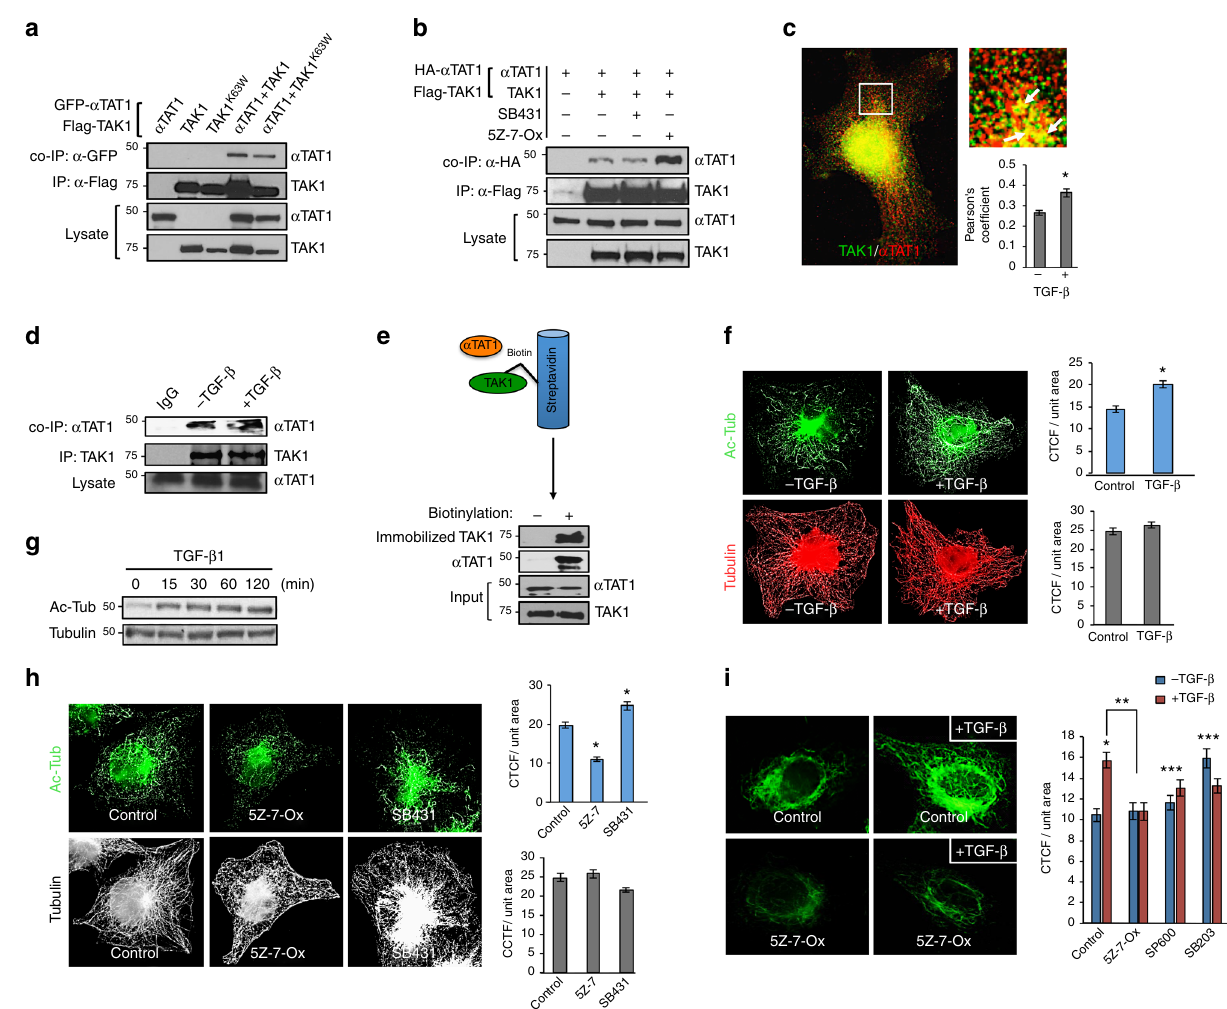
Fig. 1 TAK1 directly binds α TAT1 to promote MT acetylation. a COS-7 cells expressing HA- α TAT1 WT, Flag-TAK1 WT, or Flag-TAK1 kinase-dead (K63W) were immunoprecipitated with Flag antibody. b COS-7 cells expressing HA- α TAT1 WT with or without Flag-TAK1 WT were treated with SB431542 (30 μ M) or (5Z)-7-Oxozeaenol (20 μ M) for 30 min before immunoprecipitation with Flag antibody. c COS-7 cells were treated with TGF- β 1 (200 pM) for 30 min before fi xing and then imaged for endogenous α TAT1 (C6ORF) and TAK1 immuno fl uorescence staining. At least 15 cells per condition (3 ROIs per cell) were quanti fi ed using Image J plugin JACoP to determine Pearson ’ s correlation coef fi cient. Error bars represent SEM from three independent experiments (* p = 0.0001). d COS-7 cells were treated with TGF- β 1 (200 pM) for 30 min and the lysates were immunoprecipitated with either IgG control or α TAT1 (C6ORF) antibody. e Puri fi ed α TAT1 and TAK1 were incubated with biotinylated TAK1 immobilized to streptavidin agarose. As a negative control, α TAT1 and non-biotinylated TAK1 were incubated in streptavidin agarose. f COS-7 cells were treated with TGF- β 1 (200 pM) for 30 min before fi xation, then imaged for acetyl-tubulin (top) and total tubulin (bottom) immuno fl uorescence staining. The images were quanti fi ed for corrected total cell fl uorescence (CTCF) per unit area using Image J. Quanti fi cation was based on data collected from 50 cells per condition. The images are representative of three independent experiments, n = 3. Error bars represent SEM and type 2 t -test results show relative to control: * p < 0.05. g Western blot analysis of acetyl and total tubulin post TGF- β 1 (200 pM) treatment for 0, 15, 30, 60, and 120 min in COS-7 cells. h COS-7 cells were treated with (5Z)-7-Oxozeaenol (20 μ M) or SB431542 (30 μ M) for 30 min before fi xation, then imaged for Acetyl-tubulin (top) and total tubulin (bottom three) immuno fl uorescence staining. At least 50 cells per condition were quanti fi ed for CTCF using Image J. The images are representative of three independent experiments, n = 3. Error bars represent SEM and type 2 t -test results show relative to control: * p < 0.05. i HeLa cells were pre-treated with (5Z)-7- Oxozeaenol (20 μ M), SP600125 (10 μ M), or SB203580 (20 μ M) for 30 min and then subjected to TGF- β 1 (200 pM) for 30 min before fi xation. The images represent Acetyl-tubulin immuno fl uorescence staining and were quanti fi ed for CTCF using Image J. Quanti fi cation was based on data collected from at least 30 cells per condition. The images are representative of three independent experiments, n = 3. Error bars represent SEM. Relative to control: * p < 0.05; ** p < 0.05;